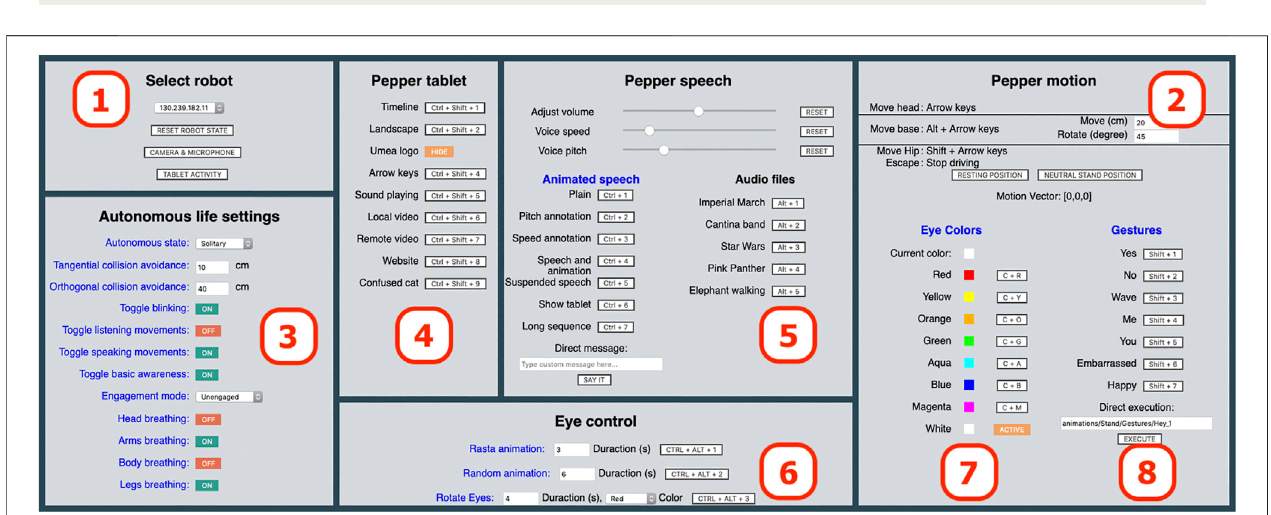
FIGURE 3 | The WoZ4U GUI for Pepper robots, comprising parts (1 – 8) with the following functionalities: (1) Connection to robot and monitoring, (2) Motion and rotation of head and base, (3) Autonomy con fi guration, (4) Tablet control, (5) Speech and audio control, (6) and (7) Eye control, and (8) Gesture control.